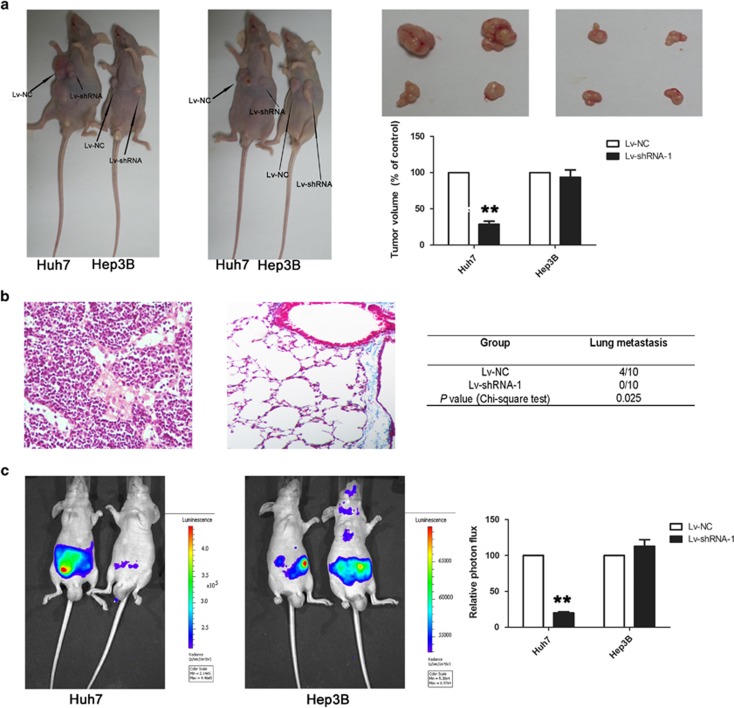
Linc00974 downregulation suppressed tumor growth and metastasis in vivo. (a) Bilateral axillary of BALB/C nude mice were subcutaneously transplanted with Huh7 or Hep3B stably expressed with Linc00974 shRNA (left axilla) or control (right axilla) (n=5). As was indicated by arrows, 4 weeks after implantation, Linc00974 decreased Huh7 attenuated tumor growth in nude mice. The volume of each tumor was calculated as the length × width2 × 0.5. The tumor volume of cells treated with controls was normalized to 100%. Data were presented as the mean±S.E.M. *Indicates a significant difference compared with controls (P<0.05). (b) Representative figures of tail vein xenograft model indicated lung colonization, which was formed in Huh7 cells compared with controls (n=10). The number of mice with metastastic foci in the lung was calculated in each group, as presented in the table. Four out of the 10 mice in Huh7 treated with controls presented lung colonization while no metastatic foci were obtained in cells treated with Linc00974 shRNA. The chi-squared test was used to analyze the difference (P=0.025). (c) An intraperitoneal transplantation vaccination tumor model was applied to detect abdominal metastases. As presented in the left panel, fluorescence intensity was measured using the IVIS Lumina II system. Mice injected withHuh7 resulted in the suppressed metastasis of tumor cells compared with controls; however, no statistically significant difference was obtained in Hep3B. The value of fluorescence intensity in control cells was normalized to 100% data were presented as the mean±S.E.M. *Indicates a significant difference compared with the control group (P<0.05), **P<0.01